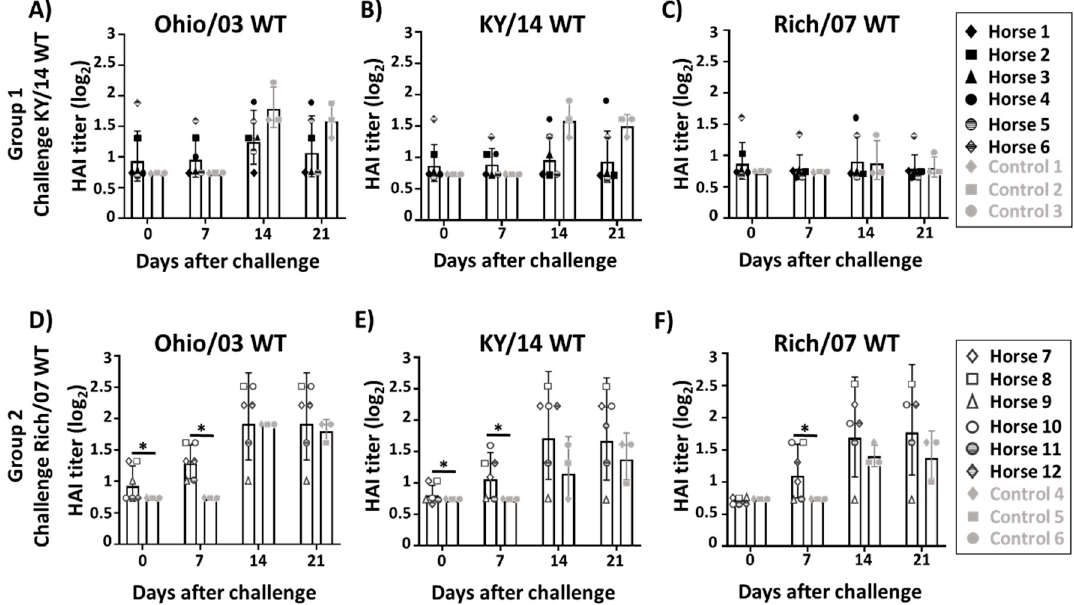
Figure 7. Induction of humoral response by the bivalent EIV LAIV before and after WT viral challenges: Fifty-seven days after prime vaccination, group 1 horses ( n = 6) were challenged with 5 × 10 7 EID 50 of the clade 1 KY / 14 WT and group 2 horses ( n = 6) were challenged with 5 × 10 7 EID 50 of the clade 2 Rich / 07 WT. Unvaccinated horses ( n = 3) were used as internal controls in each group. HAI titers against Ohio / 03 WT ( A , D ), KY / 14 WT ( B , E ), and Rich / 07 WT ( C , F ) were determined using sera collected before (day 0) and 7, 14, and 21 days after challenge of group 1 ( A – C ) and group 2 ( D – F ) horses. Individual HAI titers (log 2 ) with sera obtained from vaccinated and control horses are represented as black circles and gray squares, respectively. Bars indicate the geometric mean of the results obtained from the vaccinated or control horses, respectively. An HAI titer of 5 (equivalent to HAI log 2 of 0.71) was arbitrarily assigned to those data below the limit of detection ( < 10). * p < 0.05 was considered statistically significant.